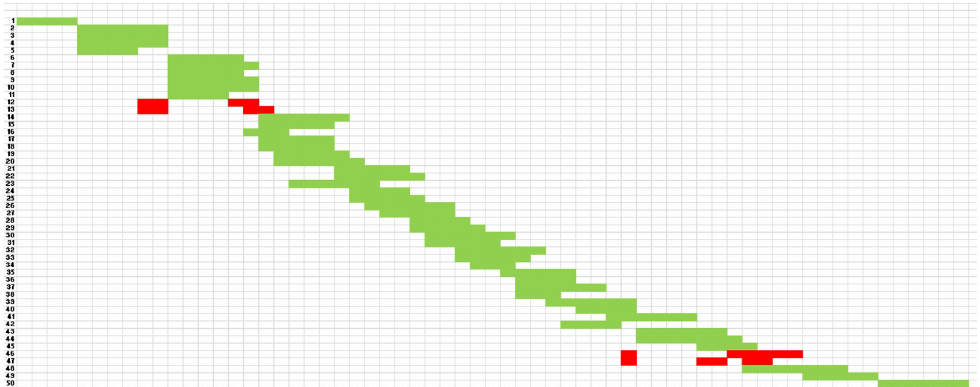
Figure 35. Gantt chart of the 10th experiment after using the proposed method